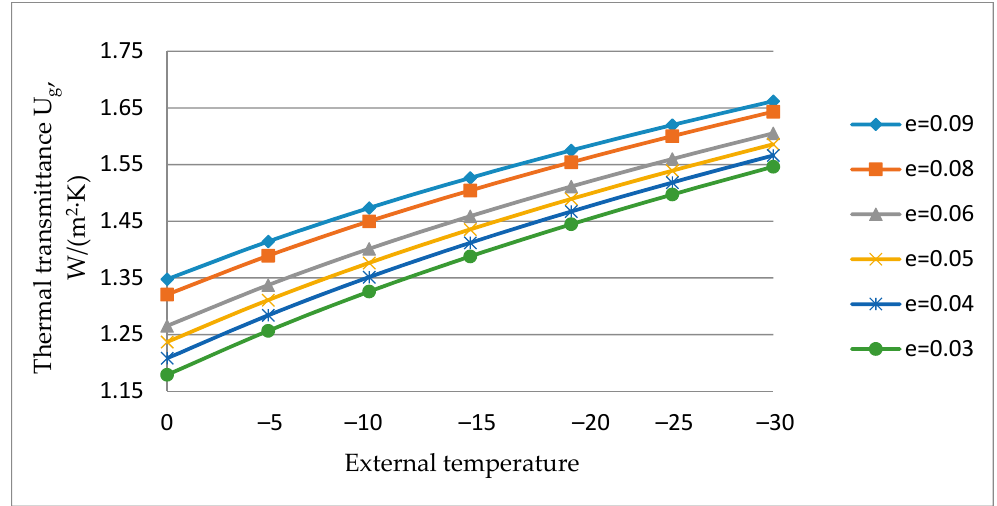
Figure 3. Dependence of the U g -value of a double-glazed IGU on Low-E coating and external air temperature.